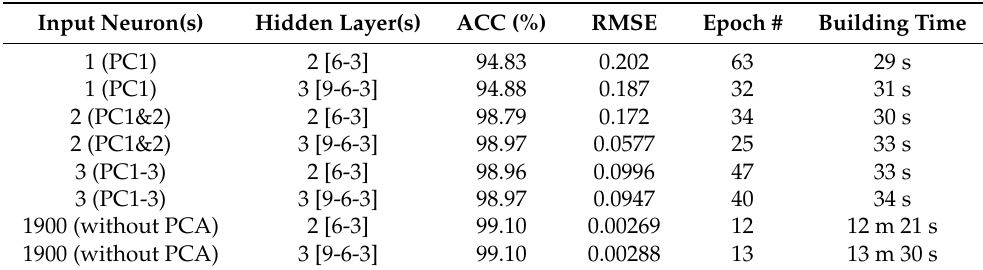
Table 2. Modify the number of input neuron(s) and the composition of the hidden layer(s) for training and discuss the performance of the